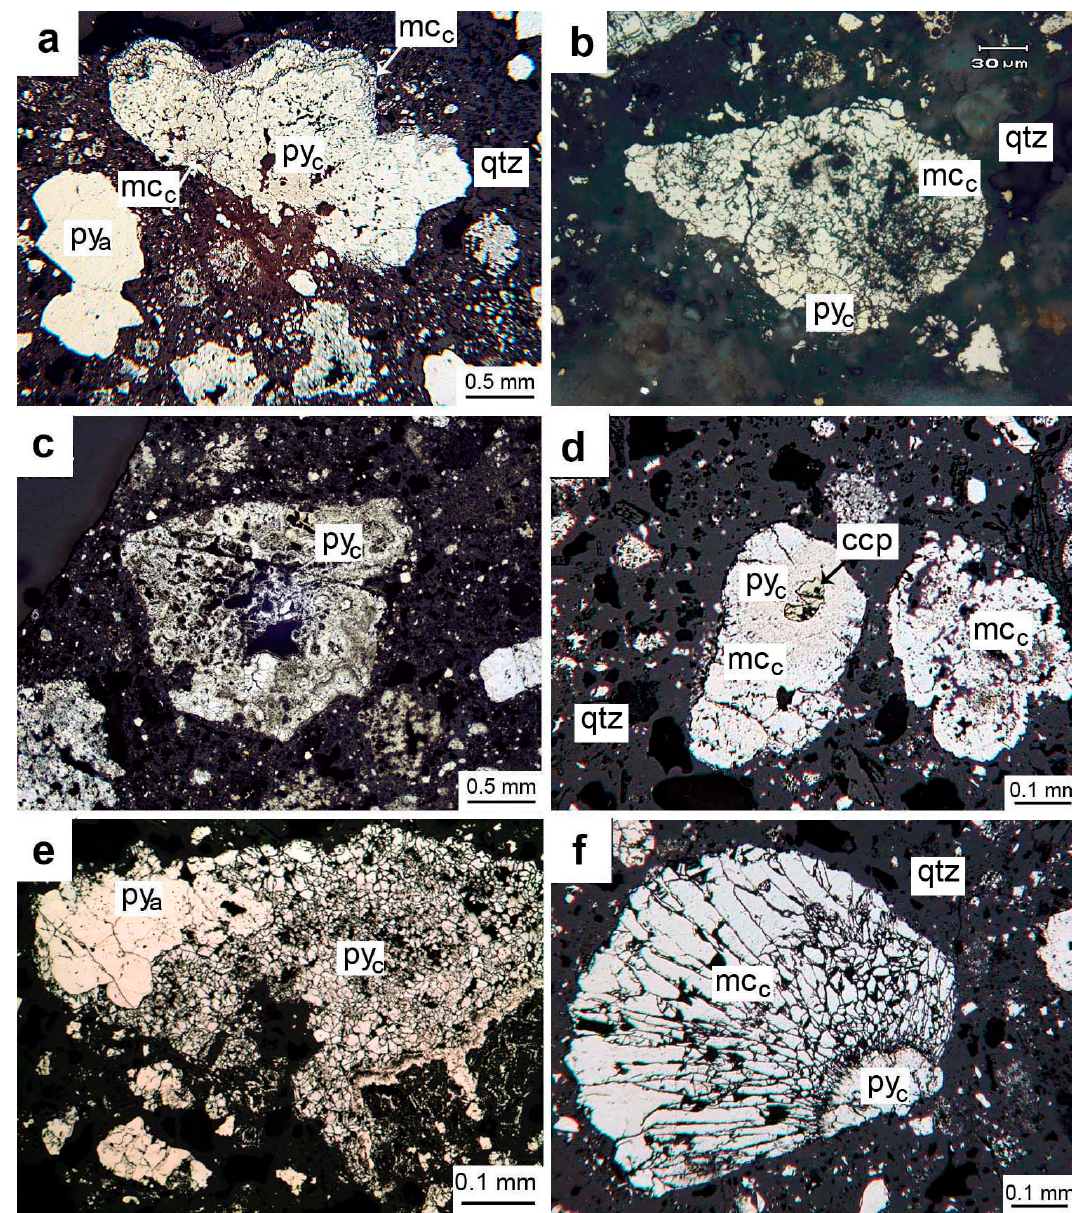
Figure 3. Clasts of fine-grained ( a , b ), colloform, porous ( c , d ), fine-crystalline ( e , f ) and radial ( a , d , f ) aggregates of pyrite and marcasite from the Semenov-3 hydrothermal field. Here and hereafter, py c , clastic pyrite; mc c , clastic marcasite; py a , authigenic pyrite; mc a , authigenic marcasite; ccp, chalcopyrite; qtz, quartz. Reflected light.